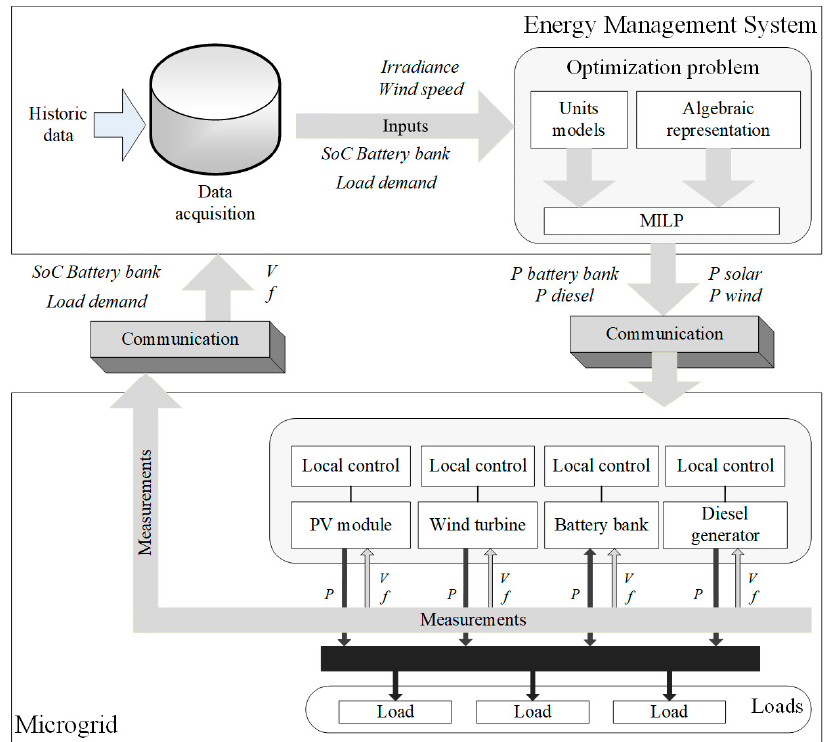
Figure 3. Microgrid topology and a flow diagram of information and measurements.